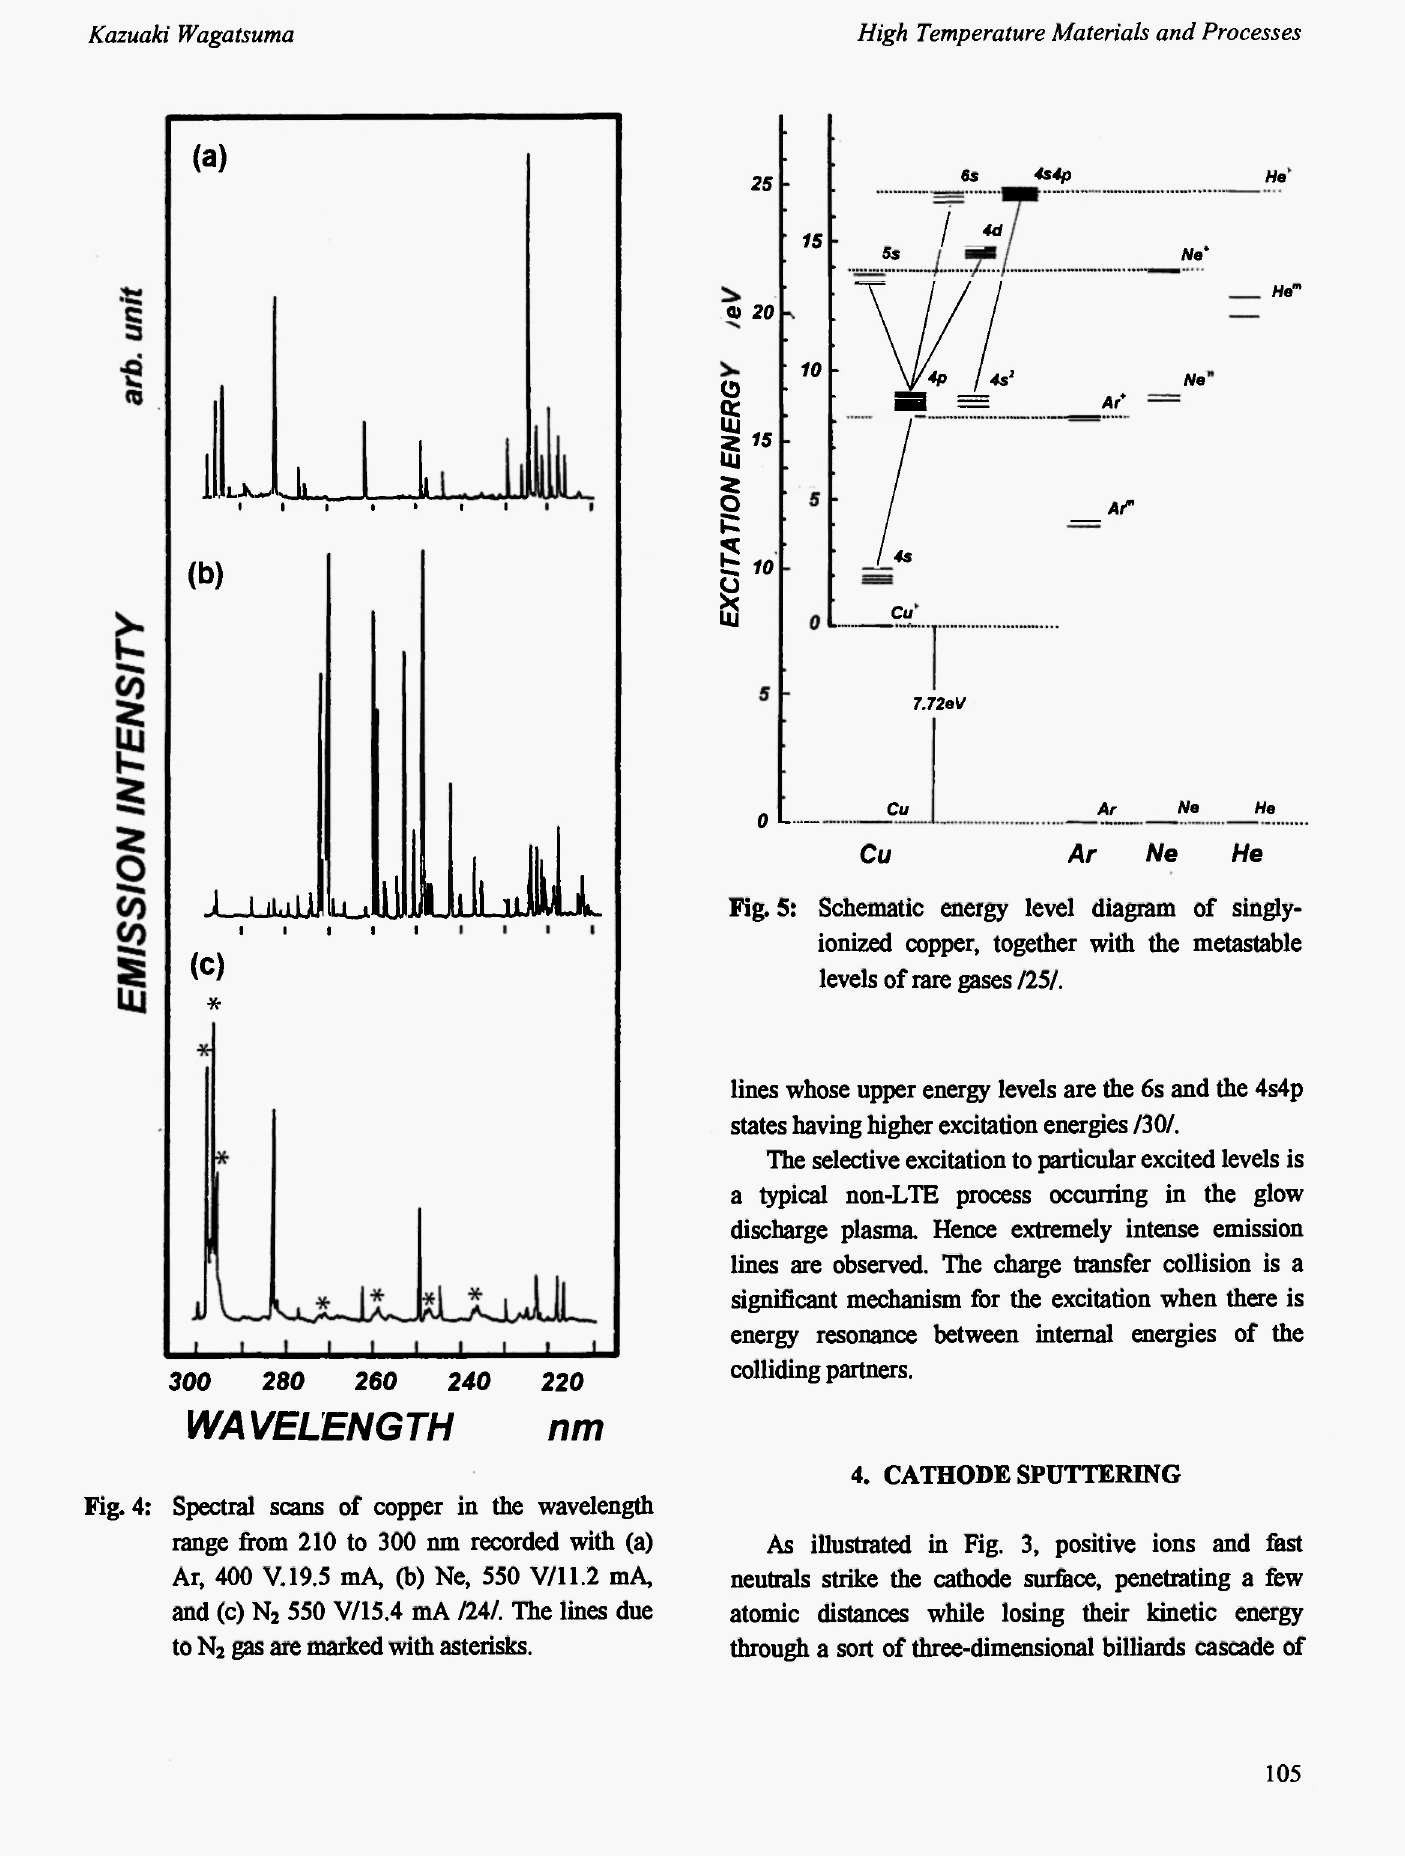
Fig. 4: Spectral scans of copper in the wavelength range from 210 to 300 nm recorded with (a) Ar, 400 V.19.5 mA, (b) Ne, 550 V/11.2 mA, and (c) N 550 V/15.4 mA /24/. The lines due 2 to N gas are marked with asterisks. 2